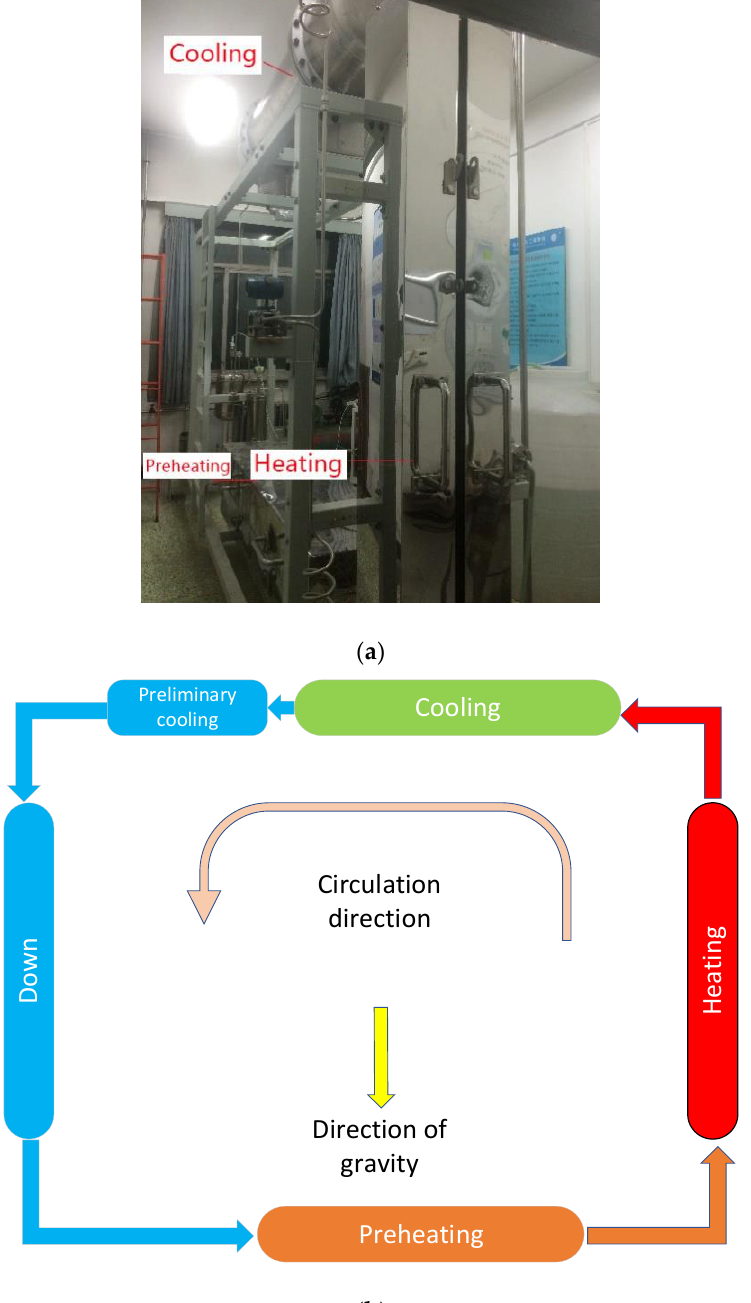
Figure 1. ( a ) Experimental equipment for supercritical water natural circulation; ( b ) Model for supercritical water natural circulation.